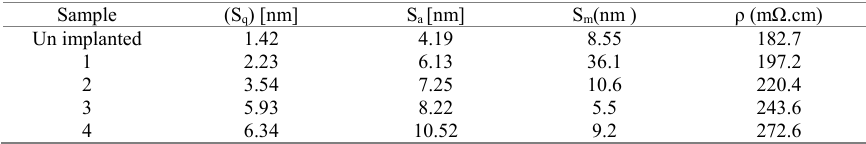
Table 4. Structural and electrical data of Ta/N sample